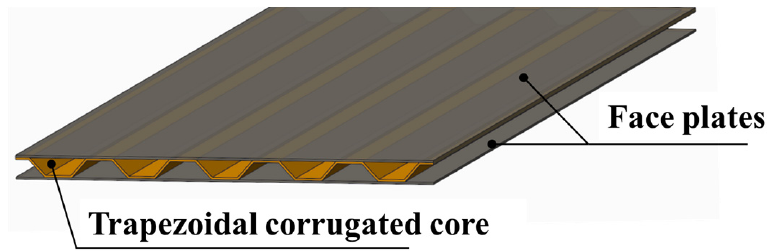
Figure 1. Model geometry of sandwich panel with trapezoidal corrugated core.